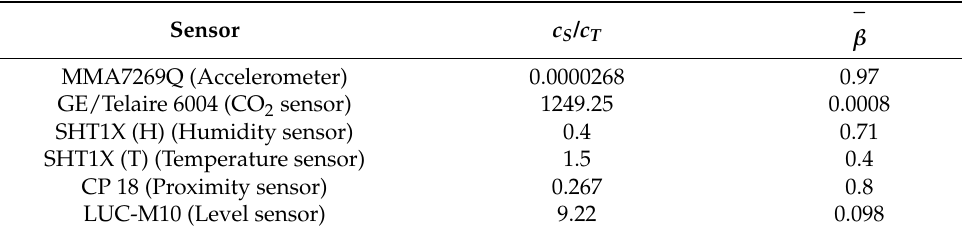
Table 1. Exemplary values of β computed from commercial-sensors parameters